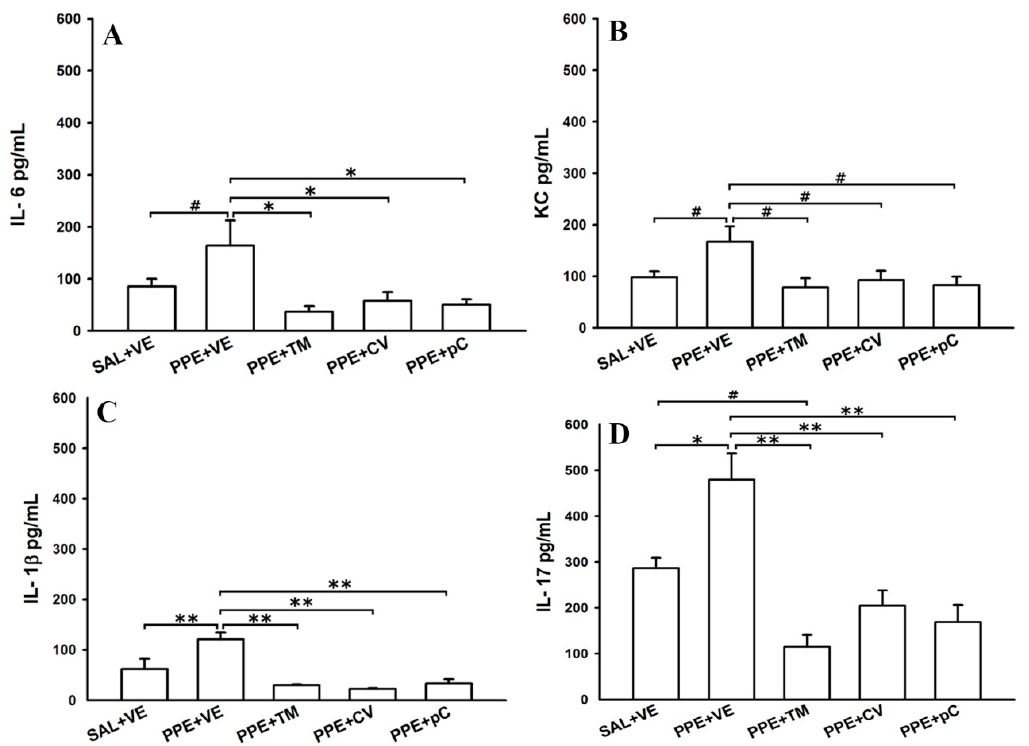
Figure 3. Effects of monoterpenes thymol, carvacrol and p -cymene in BALF cytokine levels. Data are presented as mean ± standard error (SE) ( n = 6 to 8 mice/group) of levels of: IL-6 ( A ); KC ( B ); IL-1 β ( C ); and IL-17 ( D ) detected in BALF of mice on the 28th day of the experimental protocol. SAL + VE: control group with vehicle treatment; PPE + VE: porcine pancreatic elastase instillation and vehicle treatment; PPE + TM: porcine pancreatic elastase instillation and thymol treatment; PPE + CV: porcine pancreatic elastase instillation and carvacrol treatment; PPE + pC: porcine pancreatic elastase instillation and p -cymene treatment. * p < 0.01, ** p < 0.001 and # p < 0.05.